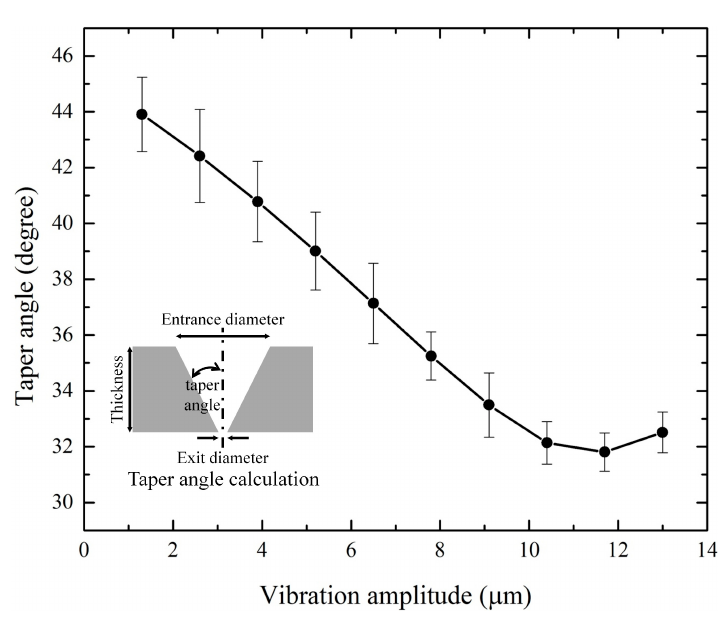
Figure 6. Plot of hole taper angle via vibration amplitude control using a vibration-assisted femtosecond laser hole drilling system. Inset: the definition of the taper angle.